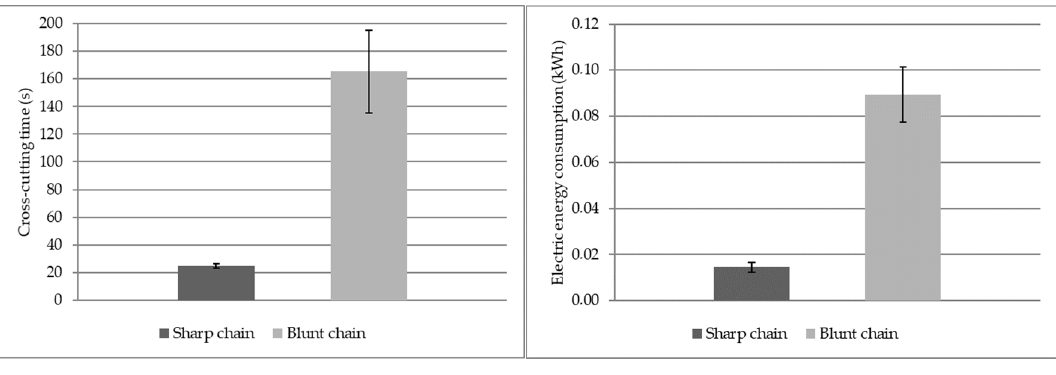
Figure 3. E ffi ciency of electric energy consumption by type of electric chain—mean and 95% confidence interval.